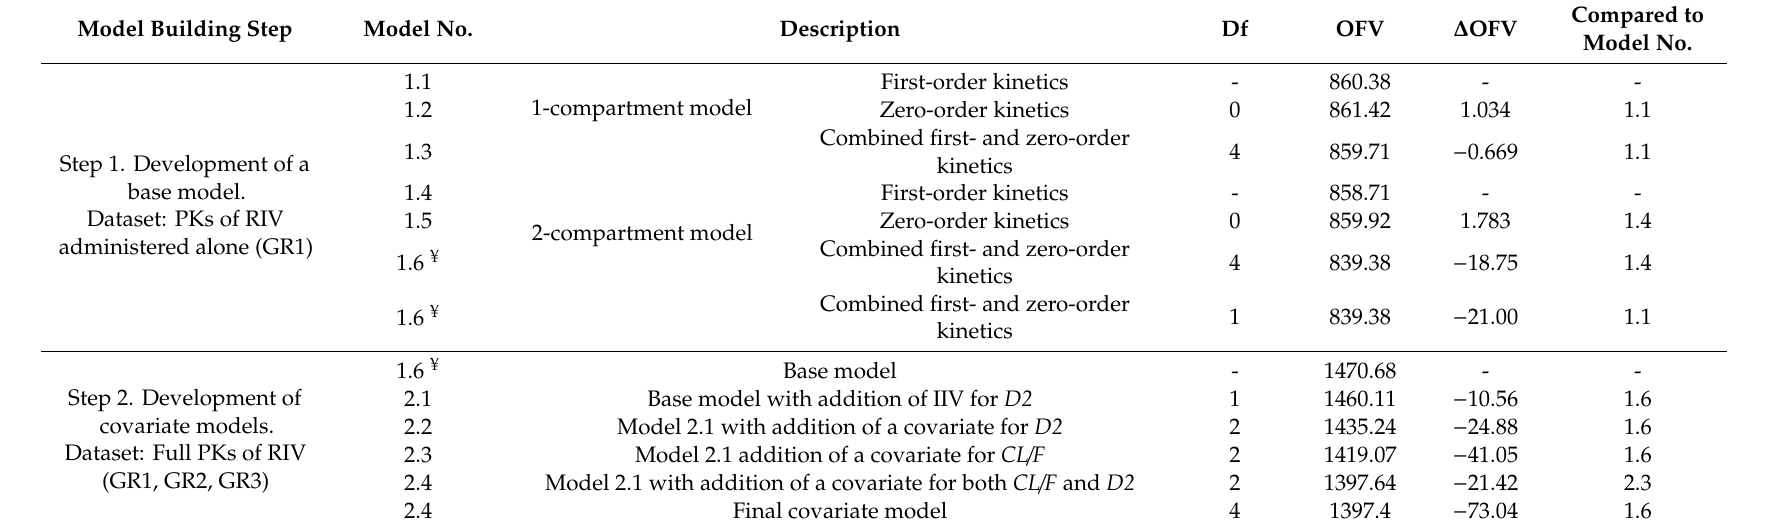
Table 3. Summary of model building steps for the pharmacokinetics of